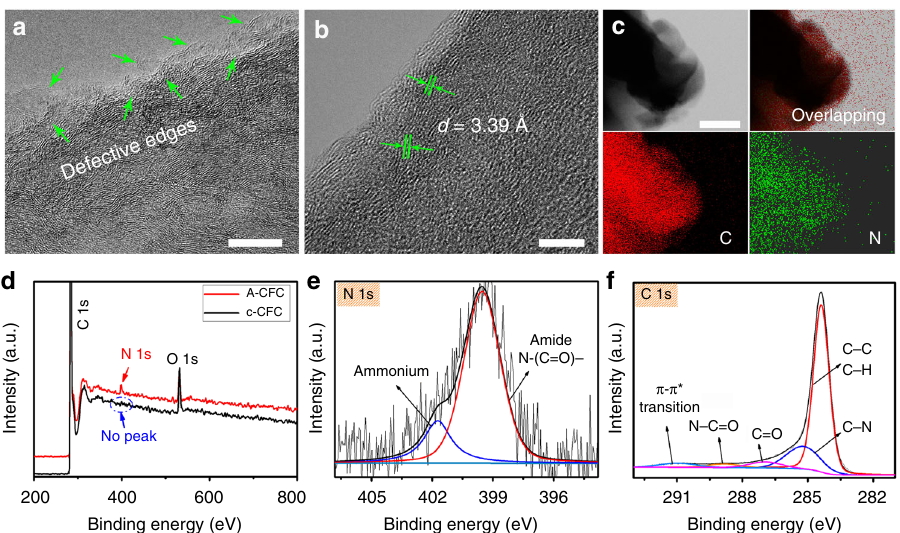
Fig. 4 TEM and XPS characterization of the A-CFC cathode. a , b High-resolution TEM images of A-CFC. c Scanning TEM image and corresponding elemental mapping of N (yellow) and C (green) elements in A-CFC. Scale bars: a 10 nm; b 5 nm; c 200 nm. d XPS survey spectra of c-CFC (dark line) and A-CFC (red line). High resolution e N 1s and f C 1s XPS spectra of